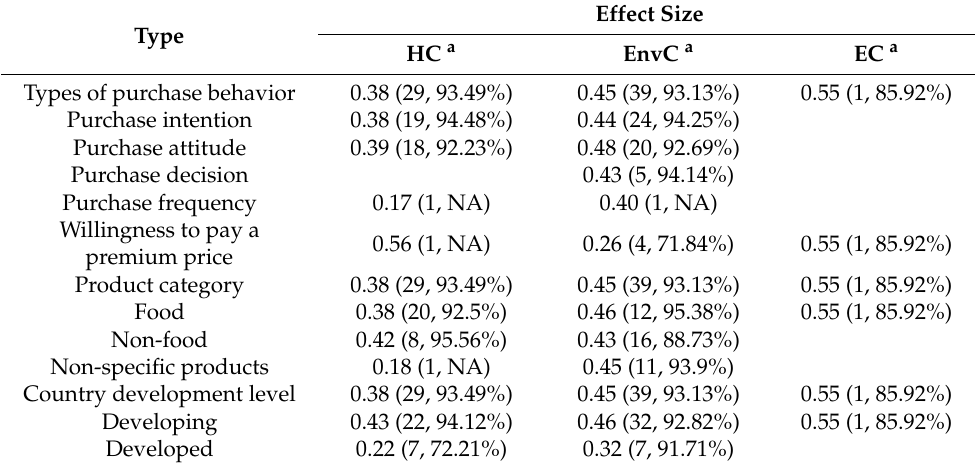
Table 3. The overall effect sizes and heterogeneity analysis of the association between health, environmental and ethical concerns and purchase behavior by types of purchase behavior, product category and country’s development